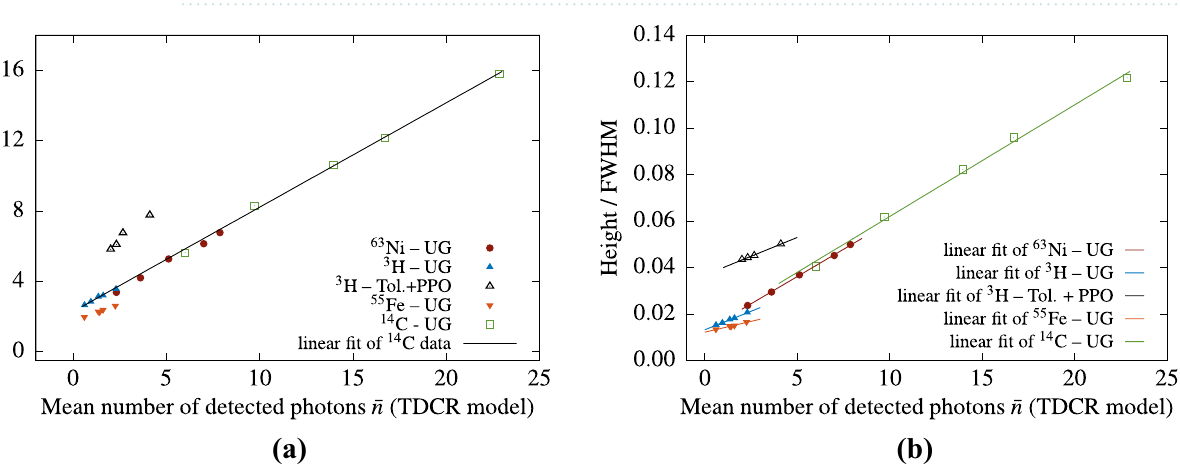
Figure 6. Kurtosis of the cross-correlation spectra—the data points are measurement results and the linear fit is 14 performed on the C data and extrapolated ( a ). The average number of detected photons is calculated from the n . The data points are from measurements of TDCR model. ( b ) Scaling the cross-correlation data H 0 /FWHM vs ¯ various LS-sources and the average number of photons is calculated from the TDCR